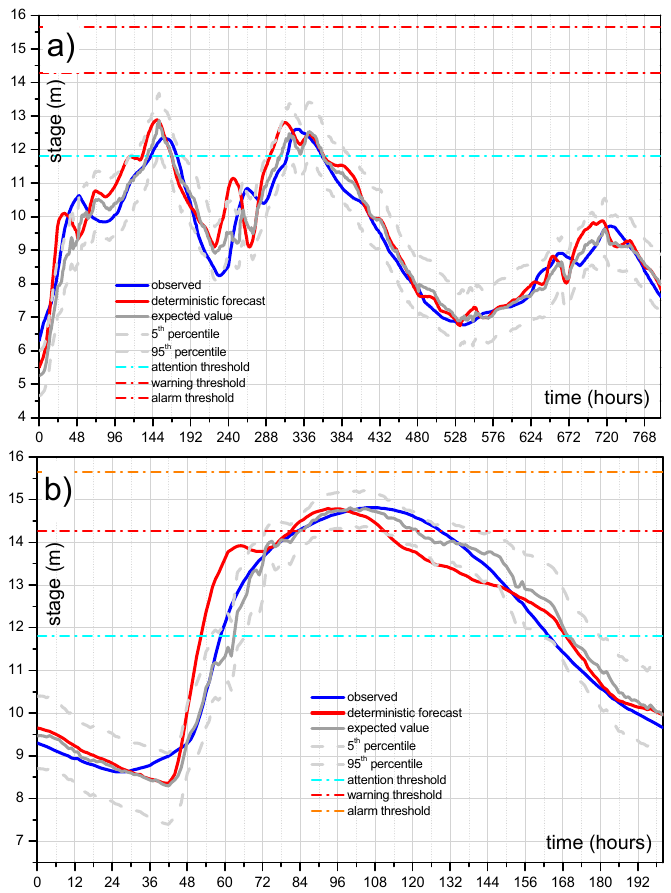
Figure 8. As for Figure 7, but for STAFOM ‐ RCM applied to the longer reach (lead ‐ time = 24 h) and for the events occurred on the period: ( a ) 24 July–26 August 2005; and ( b ) 4–12 August 2010.